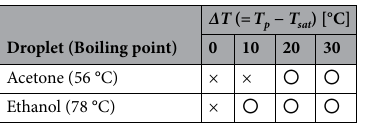
Table 1. Summary of the droplet levitation/self-propulsion conditions.